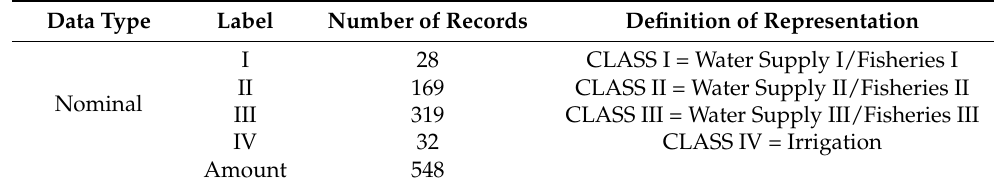
Table 3. Description of the CLASS attribute.